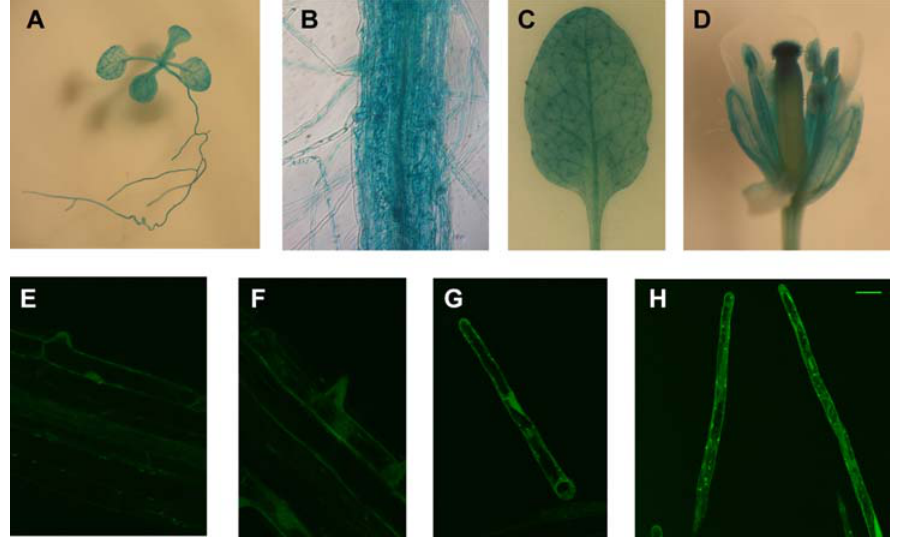
Figure 3. MRH2promoter activity in root hairs. Tissue/cell type expression patterns were revealed by histochemical examination of the 955 bp MRH2 promoter activity using the GUS (A–D) or GFP (E–G) reporters. Shown are a 2-week-old young seedling (A), part of the root with root hairs (B), a leaf (C) in which trichomes were strongly stained but epidermal cells were weakly stained, and a flower (D). Root hairs at various stages (E–H) were also shown. The bar in (H) represents 20 m m in